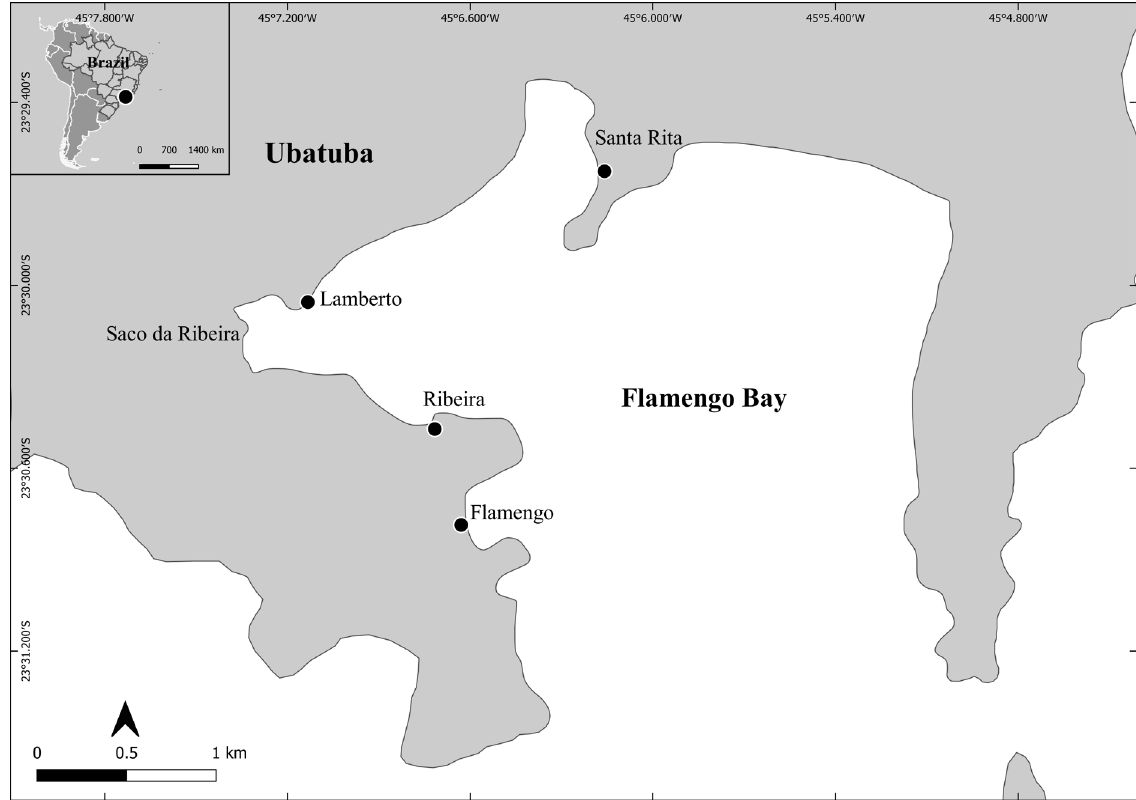
Figure 1. Map of the study area, Flamengo Bay, Ubatuba, on the north coast of São Paulo State, with the locations of the four beaches where the Sargassum fronds were collected. Inset (upper left) shows the position of the bay on the Brazilian coast, indicated by a